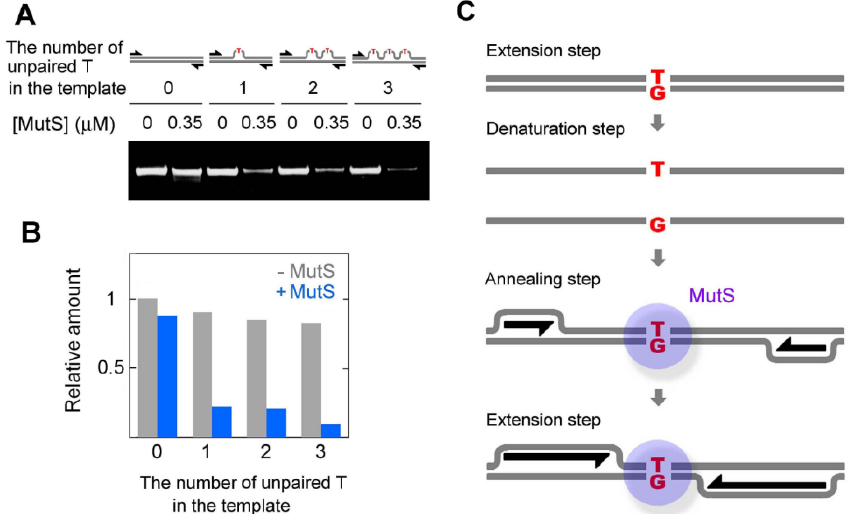
Figure 5. Effect of the number of mismatches in an 80-bp template on amplification efficiency in the presence of Tth MutS. ( A ) Templates containing zero, one, two or three unpaired T mismatches were used. PCR was performed using LA Taq Hot-Start version with perfectly matched primers in the absence or presence of 0.35 μ M Tth MutS; ( B ) Quantification of the relative amounts of amplified fragments. Gray and blue columns indicate amplification in the absence or presence of Tth MutS, respectively. The amounts of the products were normalized by that from perfectly-matched template at 0 μ M Tth MutS; ( C ) Model for the mechanism by which Tth MutS suppresses amplification from mismatched